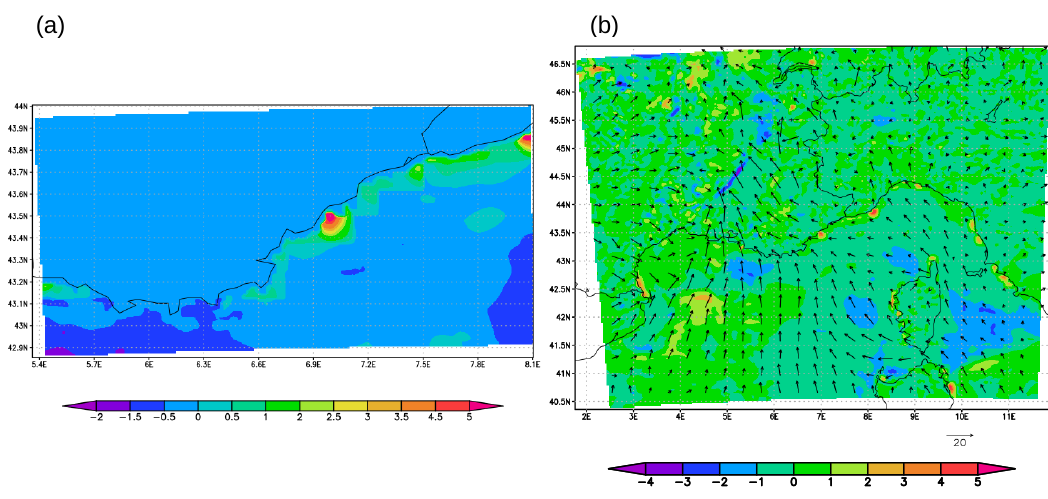
Figure 11. Panel ( a ): SST difference ( ◦ C) between satellite-derived and ECMWF analyses at 00 UTC, 3 October 2015. Panel ( b ): 17 UTC surface temperature difference (shade contour) between 3.3 km resolution W_ECM_SST and W_ECM simulations and W_ECM_SST 10 m wind field (vector m s − 1